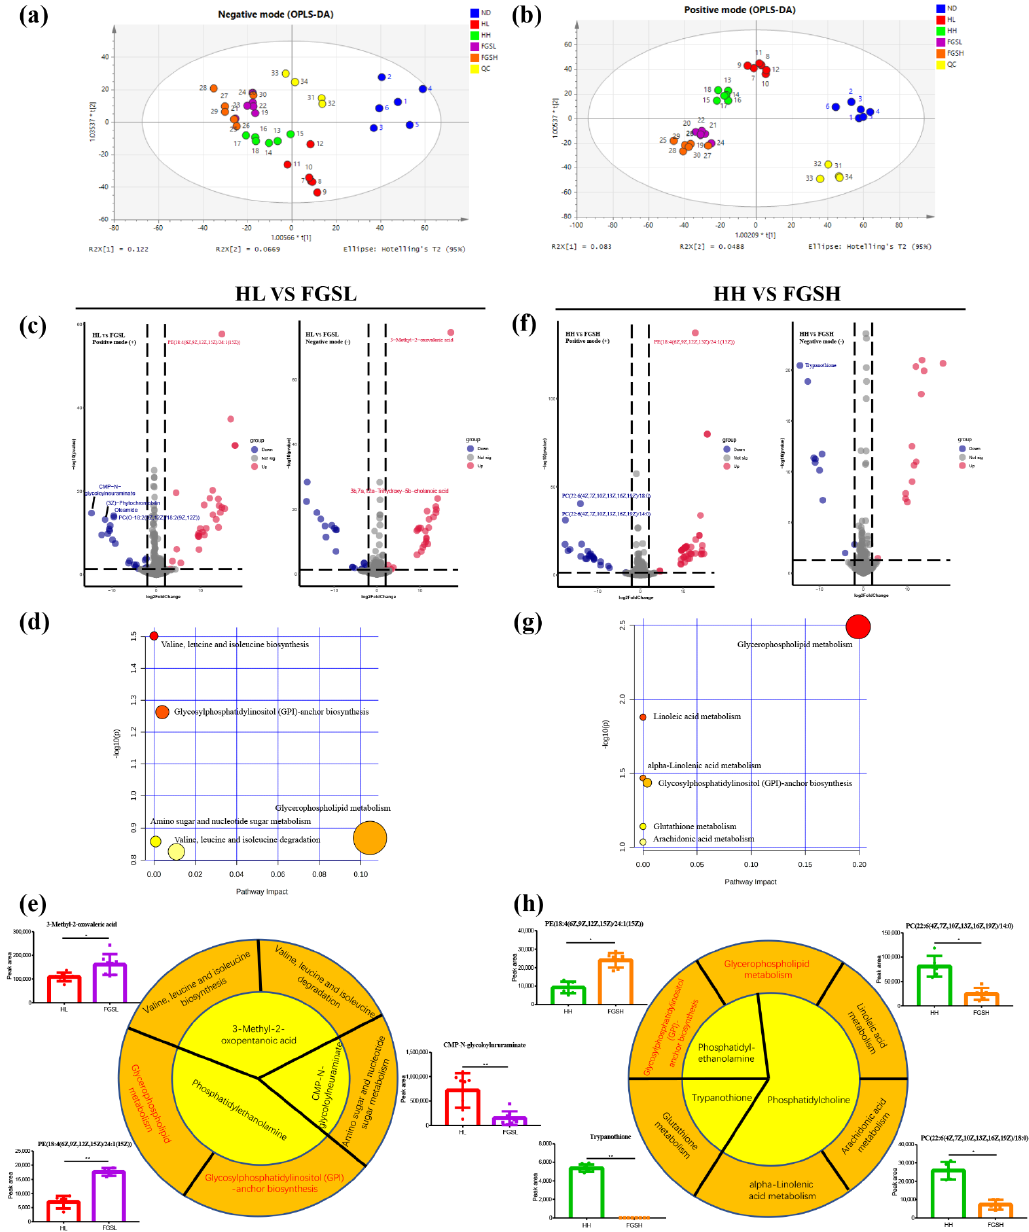
Figure 4. Honey and sugar diets have different metabolite profiles. Orthogonal projections to latent structures-discrimination analysis (OPLS-DA) score plots of metabolomics data in negative and positive modes, respectively ( a , b ). Volcano plot screening showed that the honey and sugar diet mice serum had different metabolite biomarkers ( c , f ). Moreover, the bubble chart indicates that they perturbed metabolic pathways ( d , g ). The biomarkers involved in different metabolic pathways were diverse in HL and FGSL ( e , h ). Graph bar (e and h) differences were analyzed using one-way ANOVA (* p < 0.05, ** p < 0.01). The text continues here in the Figure 2 and Table 1